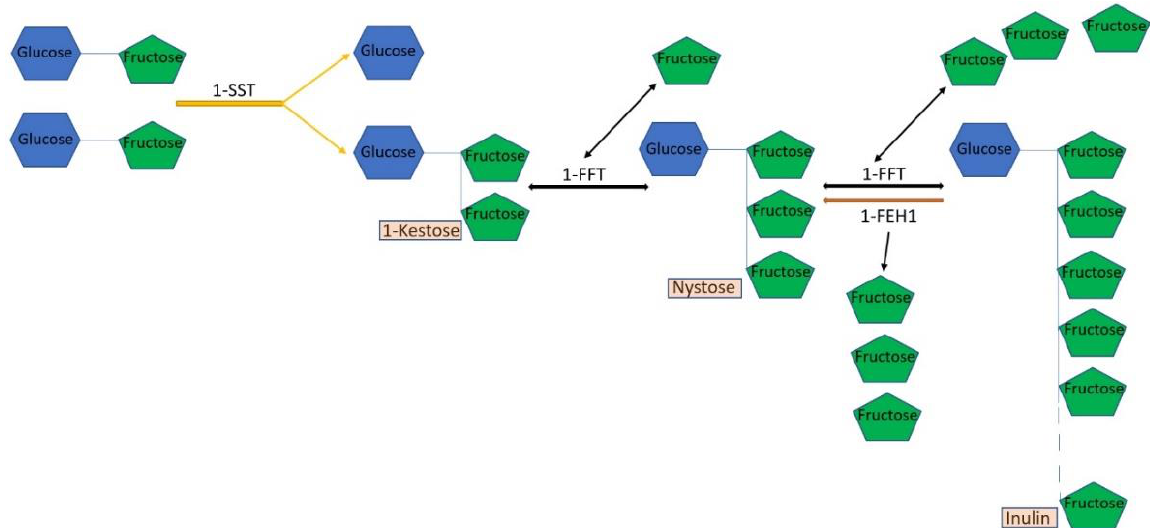
Figure 3. Biosynthesis of inulin in Taraxacum kok-saghyz . 1-SST—sucrose:sucrose-1-fructosyltransfer- Biosynthesis of inulin in Taraxacum kok-saghyz . 1-SST—sucrose:sucrose-1- ase; 1-FFT—fructan:fructan-1-fructosyltransferase; 1-FEH1 — fructan-1-exohydrolase. Taken from fructosyltransferase; 1-FFT—fructan:fructan-1-fructosyltransferase; 1-FEH1—fructan-1-exohydrolase. [61]. Taken from